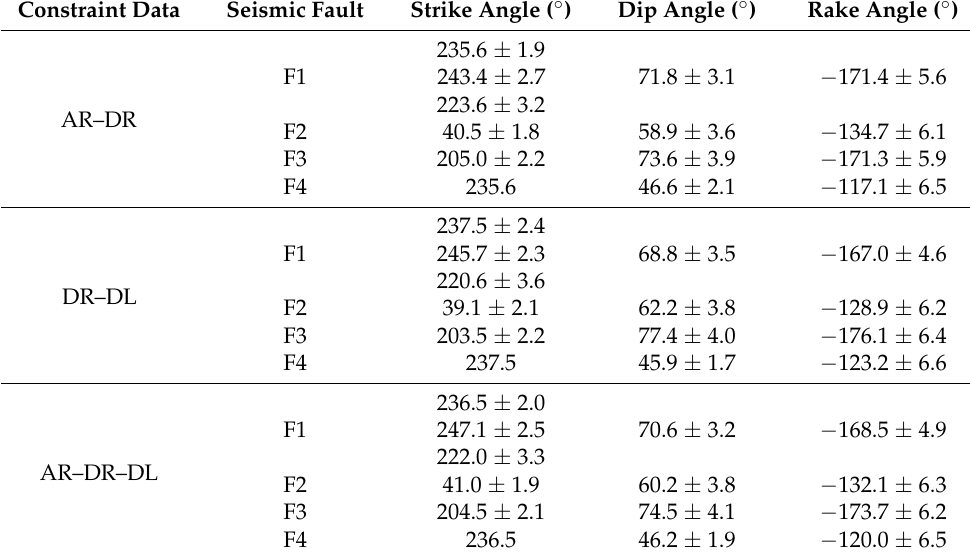
Table 2. Fault parameters of the 2016 Kumamoto earthquake solved by different data